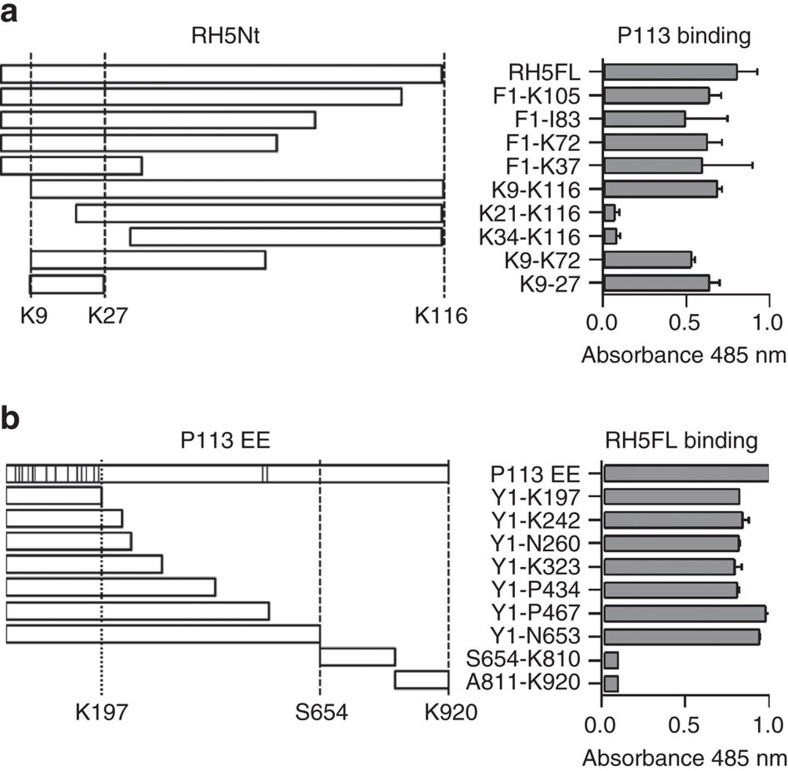
The P113-RH5 interaction interface involves a short linear sequence in RH5Nt and the cysteine-rich N-terminal domain of P113.(a) The P113 interaction interface on RH5 was mapped to 19 amino acids located within the N terminus of RH5. Fragments of RH5Nt that could be expressed as prey proteins are depicted schematically and were tested for their ability to bind a P113 bait protein by AVEXIS. The K9-K27 fragment represented the minimal binding region. (b) The RH5 interaction interface on P113 was mapped to the N terminus corresponding to a cysteine-rich region encompassed by Y1-K197. Fragments of P113, including the entire ectodomain (EE), that could be expressed as bait proteins are depicted schematically as in a with the approximate locations of the 16 cysteines marked by vertical bars. The proteins were tested for their ability to bind an RH5 prey protein by AVEXIS. Bars represent means±95% confidence intervals n=3; the experiment shown is one of two independent experiments.